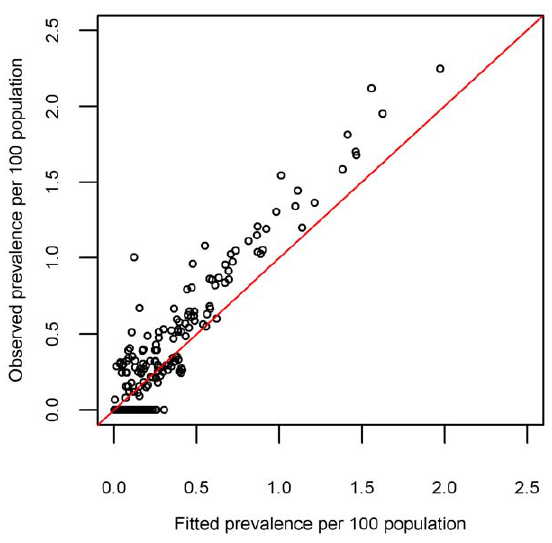
Figure 2. Fitted village prevalence versus observed village prevalence.